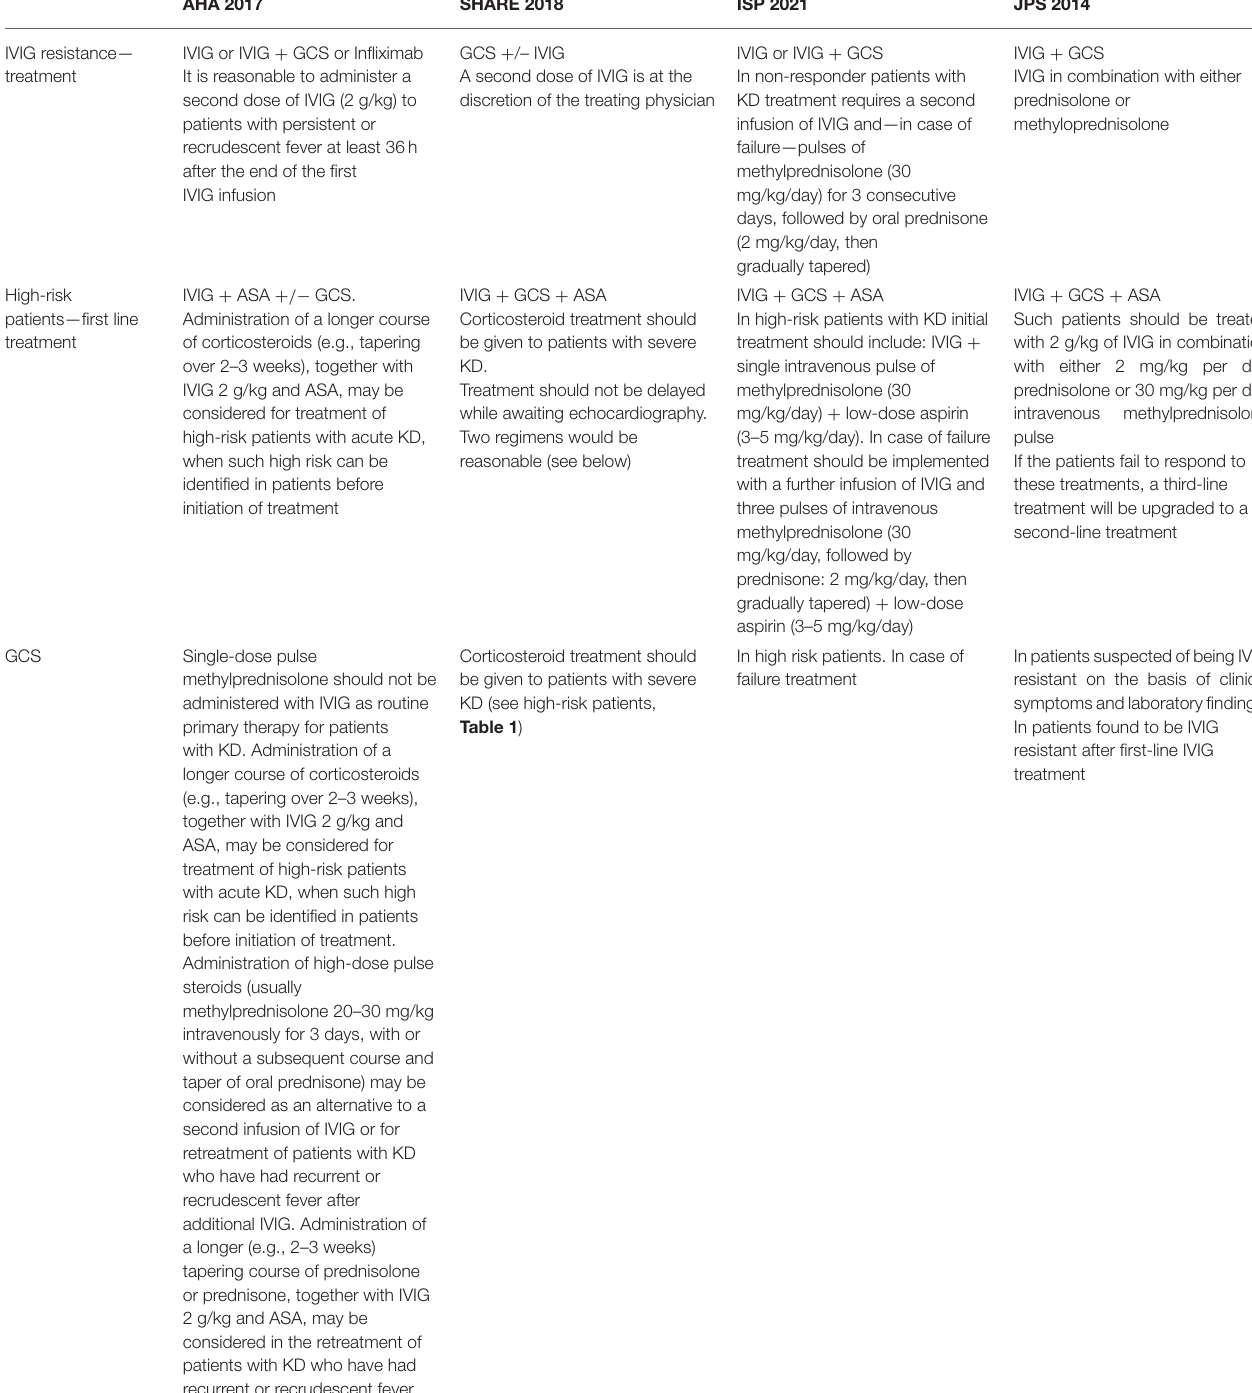
TABLE 2 | Treatment options for IVIG-resistant KD patients and refractory